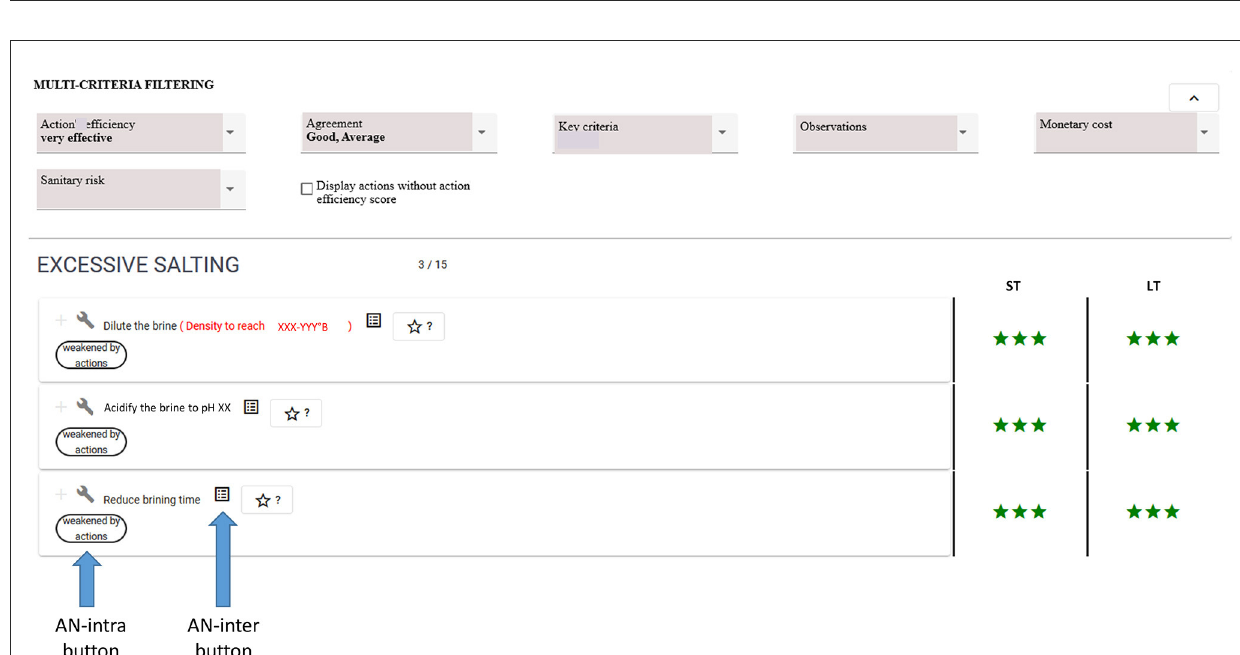
FIGURE7 MCDSS action view showing an excerpt of the list of filtered actions related to the decision tree associated with the Excessive salting situation of interest. The three stars indicate the action’s efficiency is “very effective”.